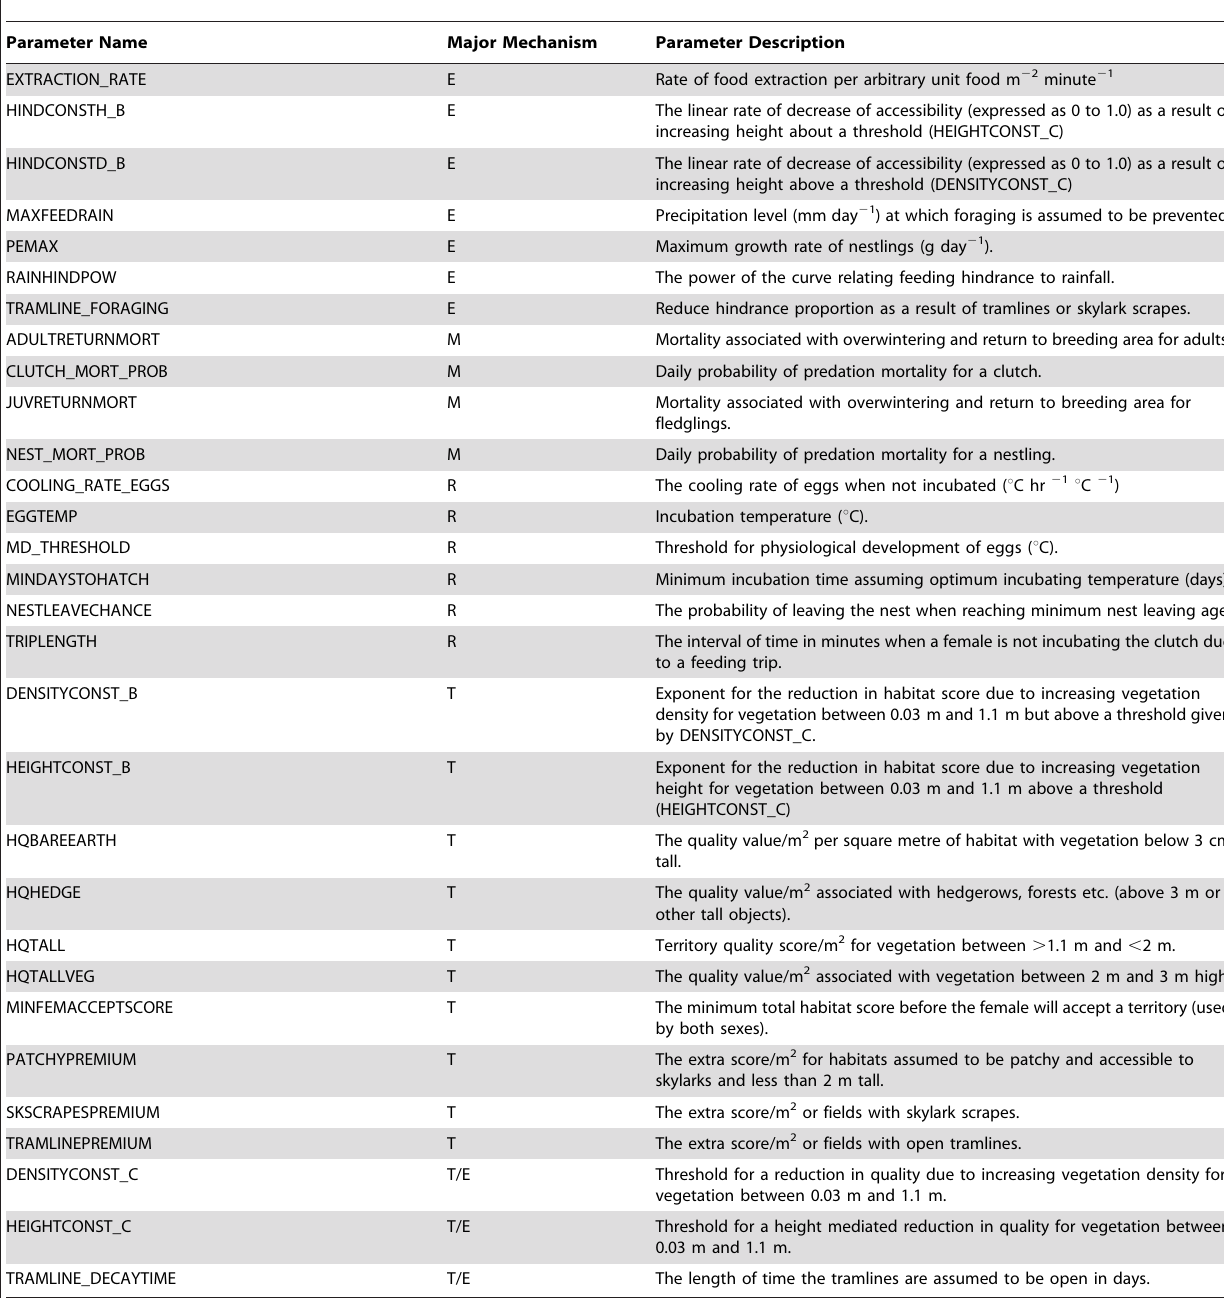
Table 2. Description of the input parameters modified during the pattern-oriented modelling procedures and subsequent sensitivity analyses with each parameter assigned to the biological mechanisms that they are related to: E =Energetics, R=Reproduction, M=Mortality and T=Territory